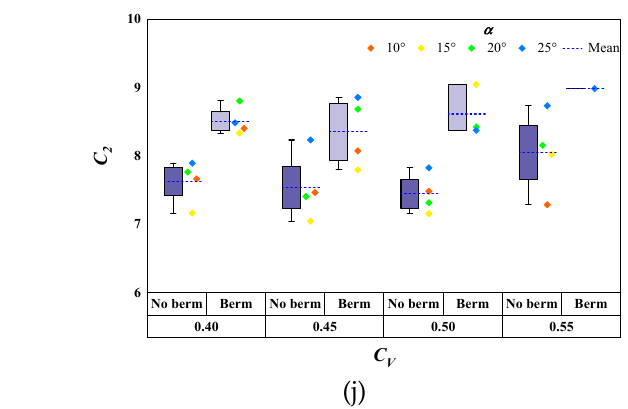
Figure 9. ( a ) μ according to α (at C V = 0.40–0.55); ( b ) μ according to C V (at α = 10°–25°); ( c ) ξ according to α (at C V = 0.40– Figure 9. ( a ) µ according to α (at C V = 0.40–0.55); ( b ) µ according to C V (at α = 10 ◦ –25 ◦ ); ( c ) ξ according to α (at 0.55); ( d ) ξ according to C V (at α = 10°–25°); ( e ) n according to α (at C V = 0.40–0.55); ( f ) n according to C V (at α = 10°–25°); ( g ) C V = 0.40–0.55); ( d ) ξ according to C V (at α = 10 ◦ –25 ◦ ); ( e ) n according to α (at C V = 0.40–0.55); ( f ) n according to C V C 1 according to α (at C V = 0.40–0.55); ( h ) C 1 according to C V (at α = 10°–25°); ( i ) C 2 according to α (at C V = 0.40–0.55); ( j ) C 2 (at α = 10 ◦ –25 ◦ ); ( g ) C 1 according to α (at C V = 0.40–0.55); ( h ) C 1 according to C V (at α = 10 ◦ –25 ◦ ); ( i ) C 2 according to α (at according to C V (at α = 10°–25°). C V = 0.40–0.55); ( j ) C 2 according to C V (at α = 10 ◦ –25 ◦